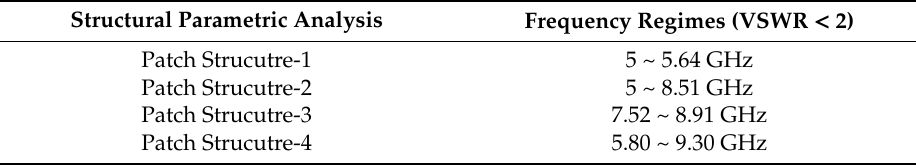
Figure 9. The effects of different radiating patch structures of antenna voltage standing wave ratio (VSWR). Table 3. Comparison of the radiating patch effects on voltage standing wave ratio. Structural Parametric Analysis Frequency Regimes (VSWR < 2) Patch Strucutre-1